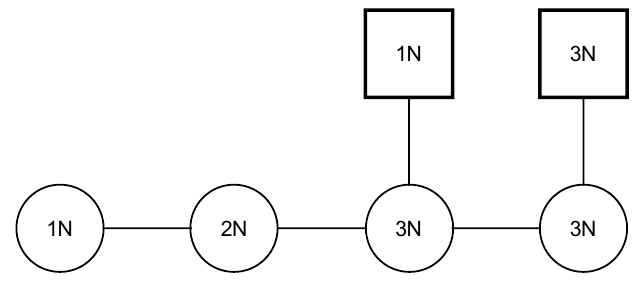
Figure 2. The quiver corresponding to the Hanany-Witten set-up